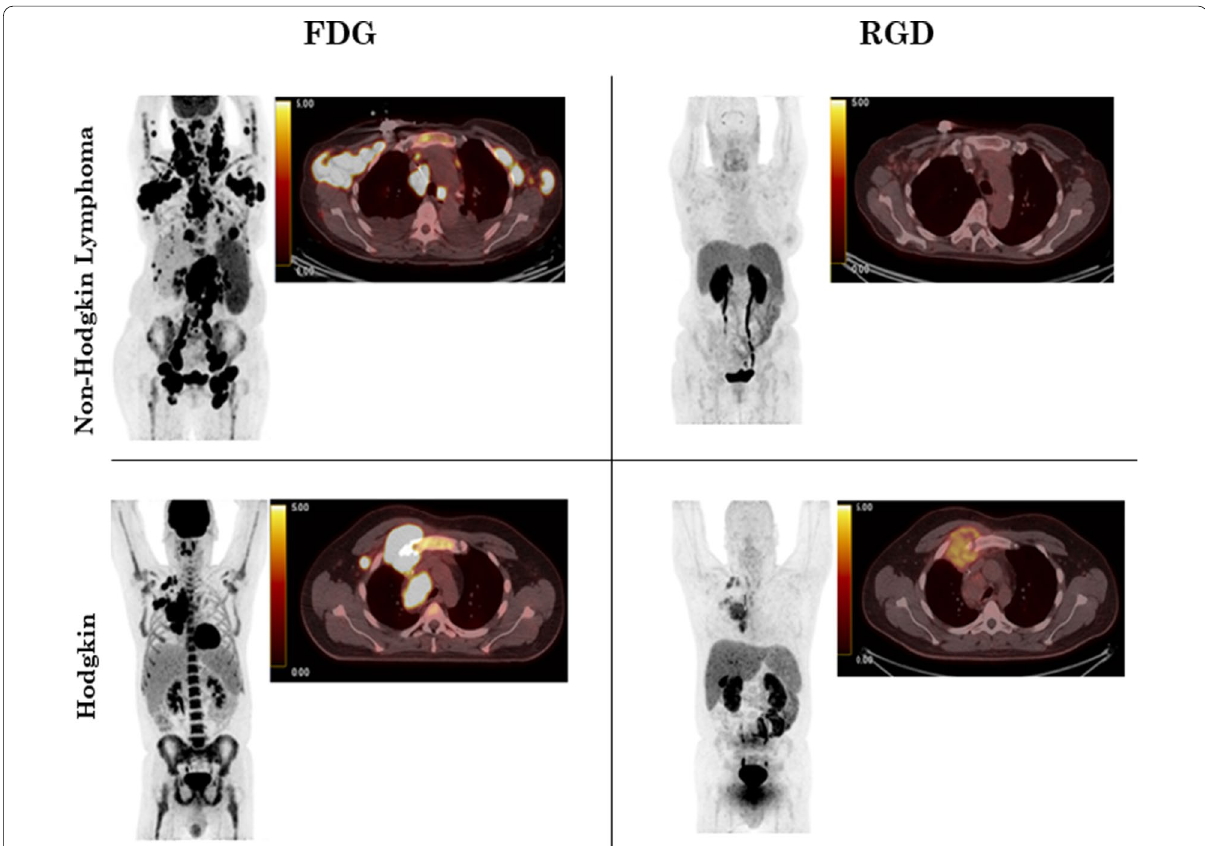
Fig. 4 FDG (left column) and RGD (right column) uptake at baseline (C0) in two patients, one presenting with non-Hodgkin lymphoma (upper row) and one with classical Hodgkin lymphoma (bottom row)